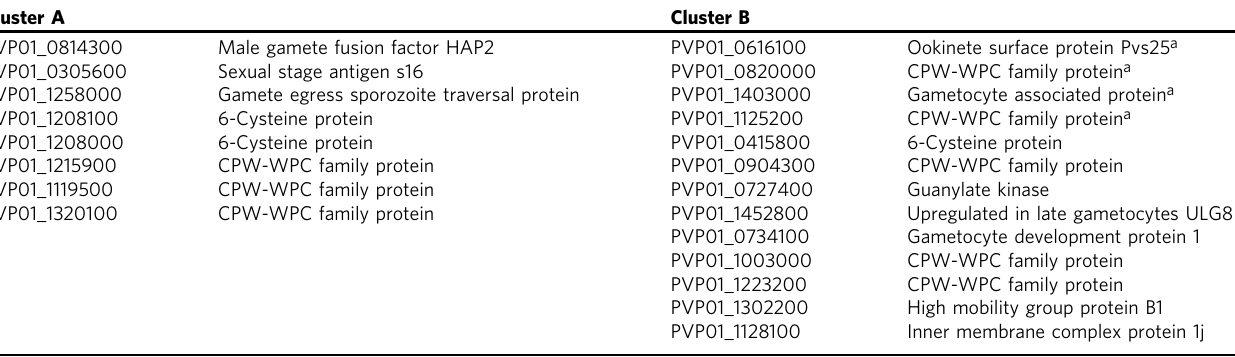
Table 1 Clustering of known gametocyte genes Cluster